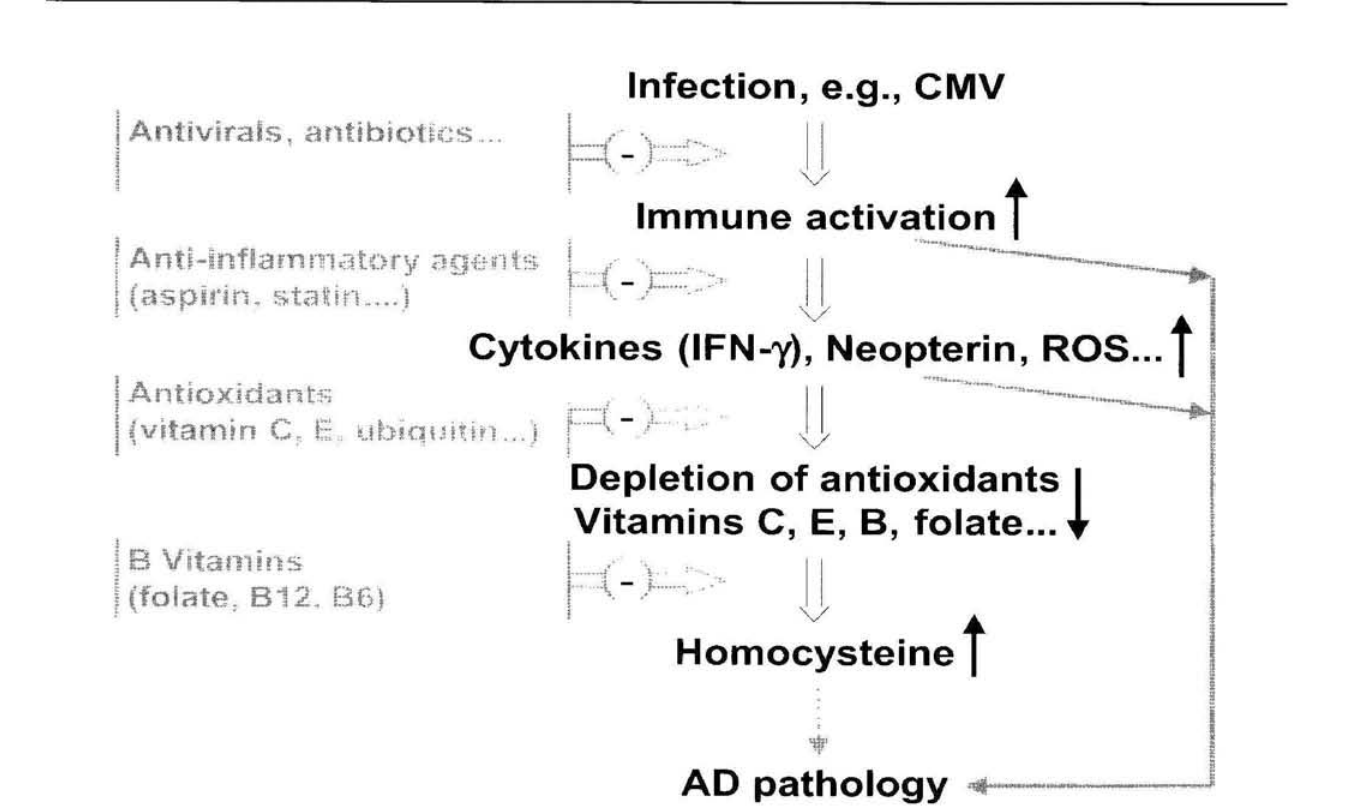
Figure 4. Hypothetic schemc of events being involved in the immunopathogenesis of dementia which finally lead to the development of hyperhomocysteinemia. Supplementation with Β vitamins is able to interfere with the con- version of homocysteine, whereas administration of antioxidant compounds like vitamin C and E or anti-inflam- matory drugs like aspirin or statins may slow-down earlier events and thereby possibly contribute to an improved inflammation status and as a consequence also homocysteine concentrations may decline. Hyperhomocystei- nemia still could contribute to the inflammatory cascade by, e.g.. enhancement of ROS effects, however, it is no longer primary in the induction of dementia pathogenesis. ( IFN-γ = interferon-γ. ROS = reactive oxygen